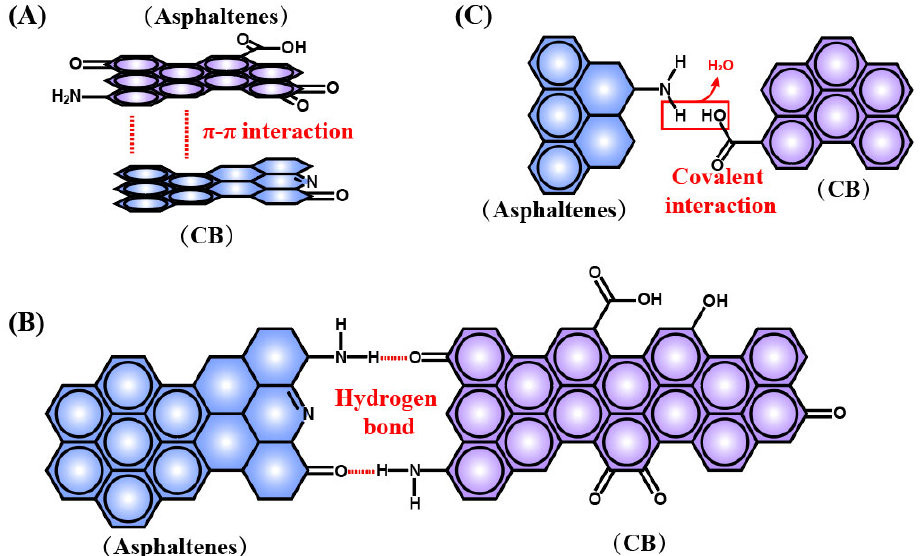
Figure 7. ( A ) Typical interactions between DR and asphalt. ( A ) π - π nonbonding intermolecular interactions; ( B ) intermolecular hydrogen bonds; ( C ) covalent interaction.